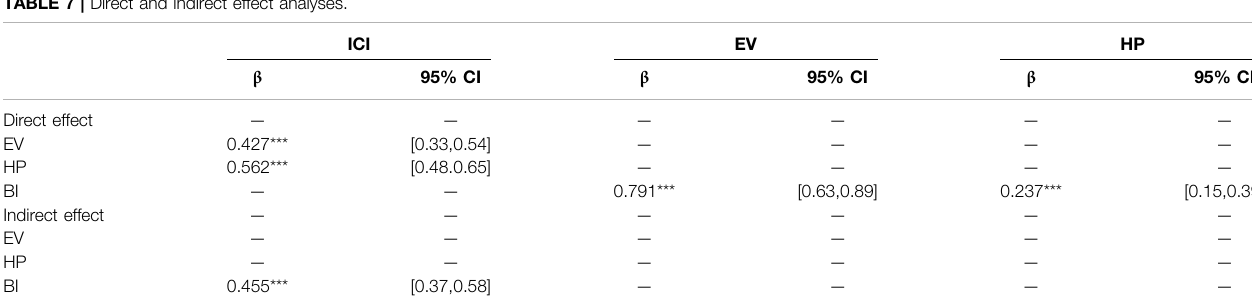
TABLE 7 | Direct and indirect effect